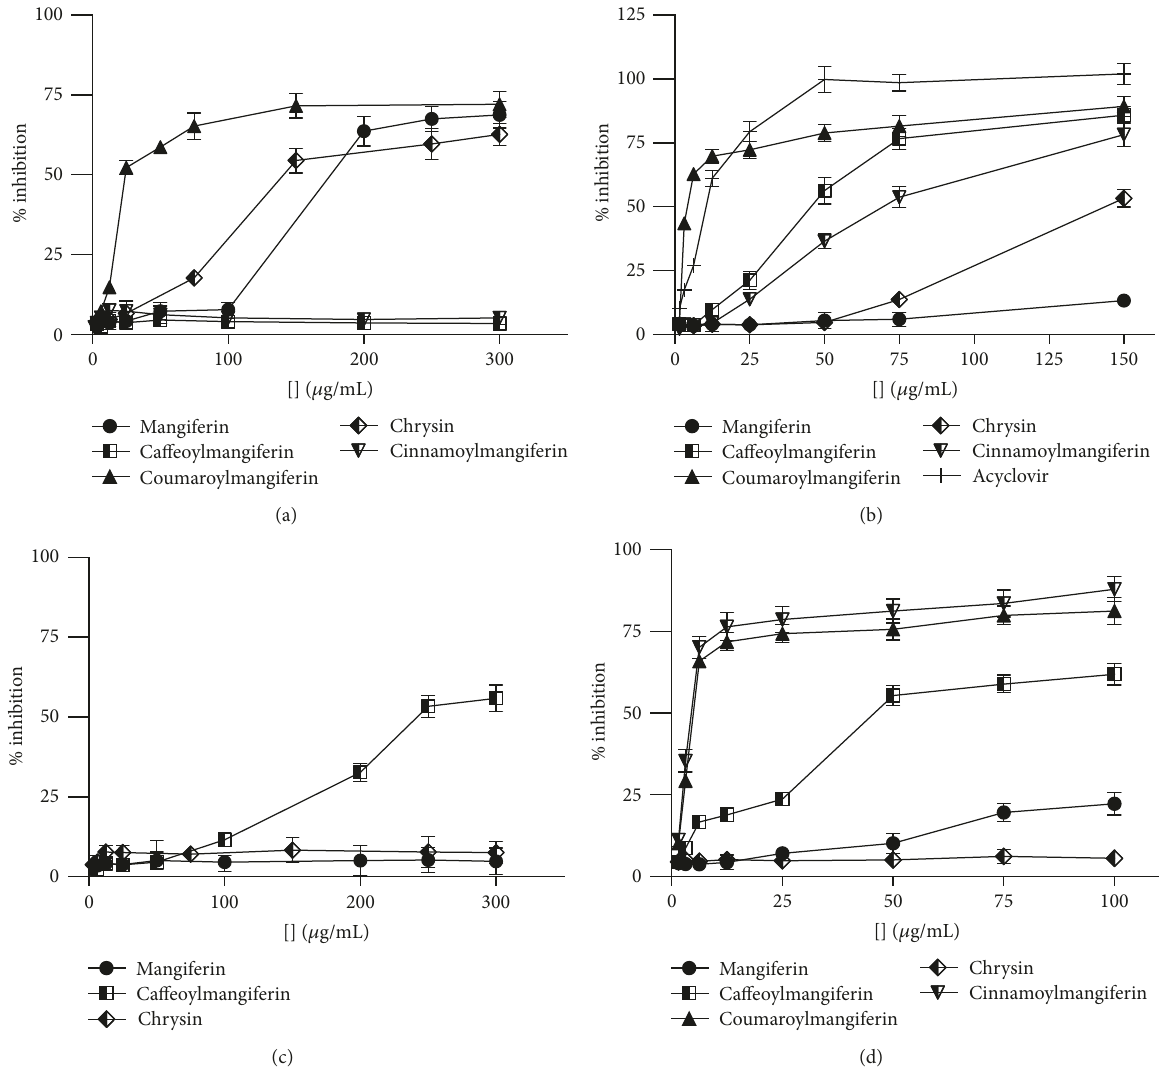
Figure 4: Dose-response curves for antiviral activity of mangiferin ( 1 ), 2 󸀠 - O - trans -caffeoylmangiferin ( 2 ), 2 󸀠 - O-trans-